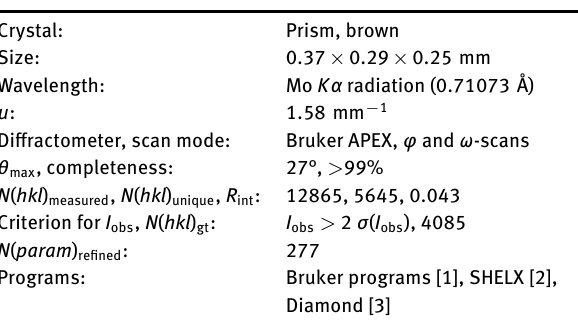
Table 1: Data collection and handling.